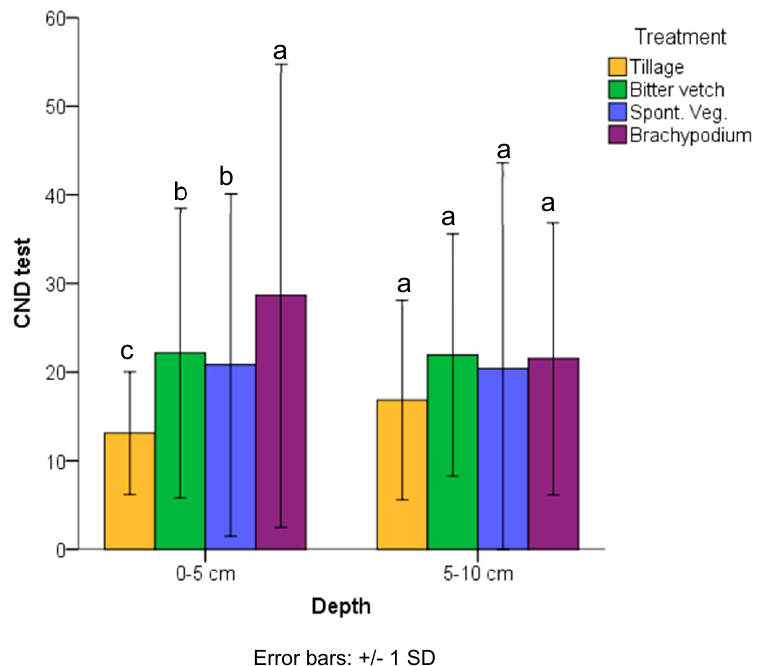
Figure 4. Counting number drop (CND) test at 0–5 and 5–10 cm depths in the different treatments in 2017. Different letters mean significant differences between treatments at p < 0.05 according to Tukey test (N = 120).